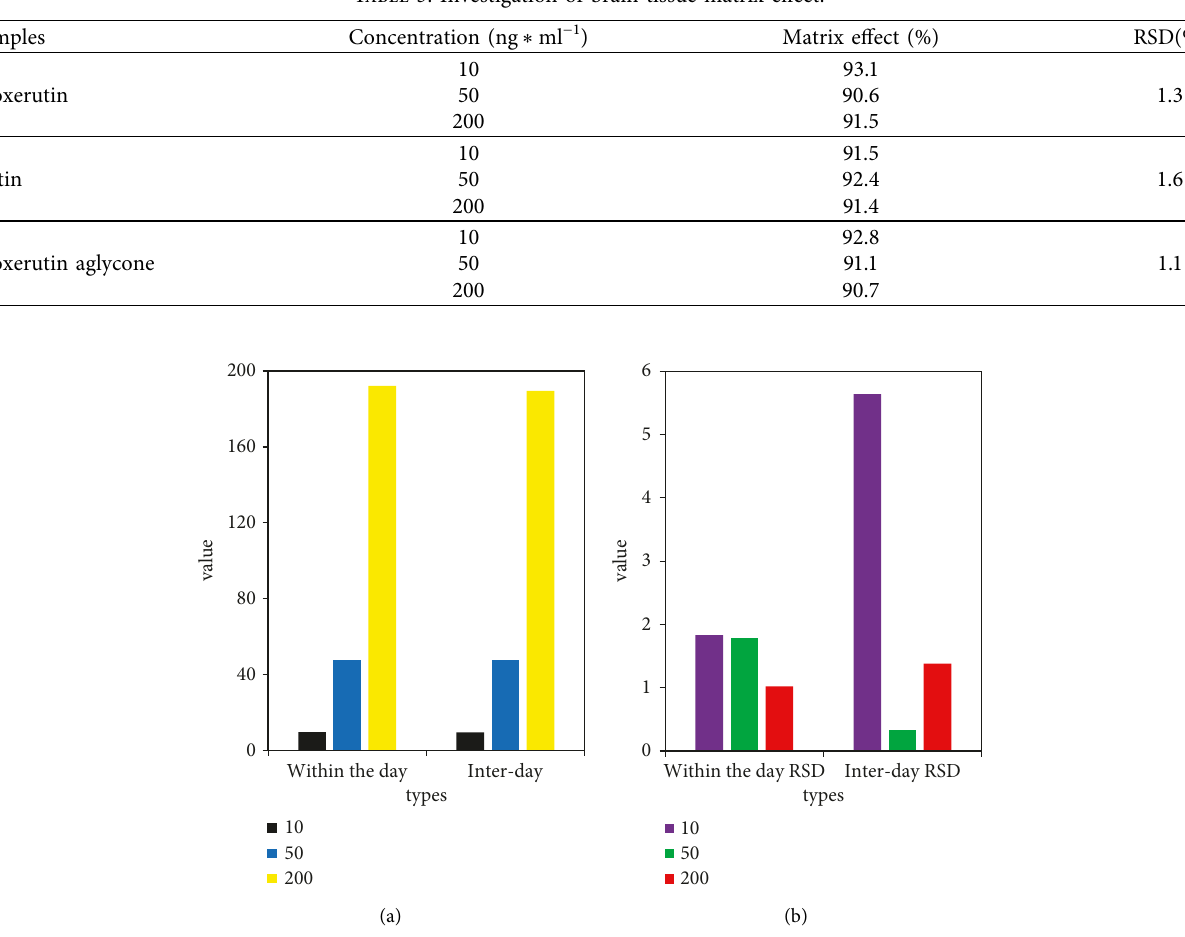
Figure 8: Extraction precision of troxerutin in mouse brain tissue.